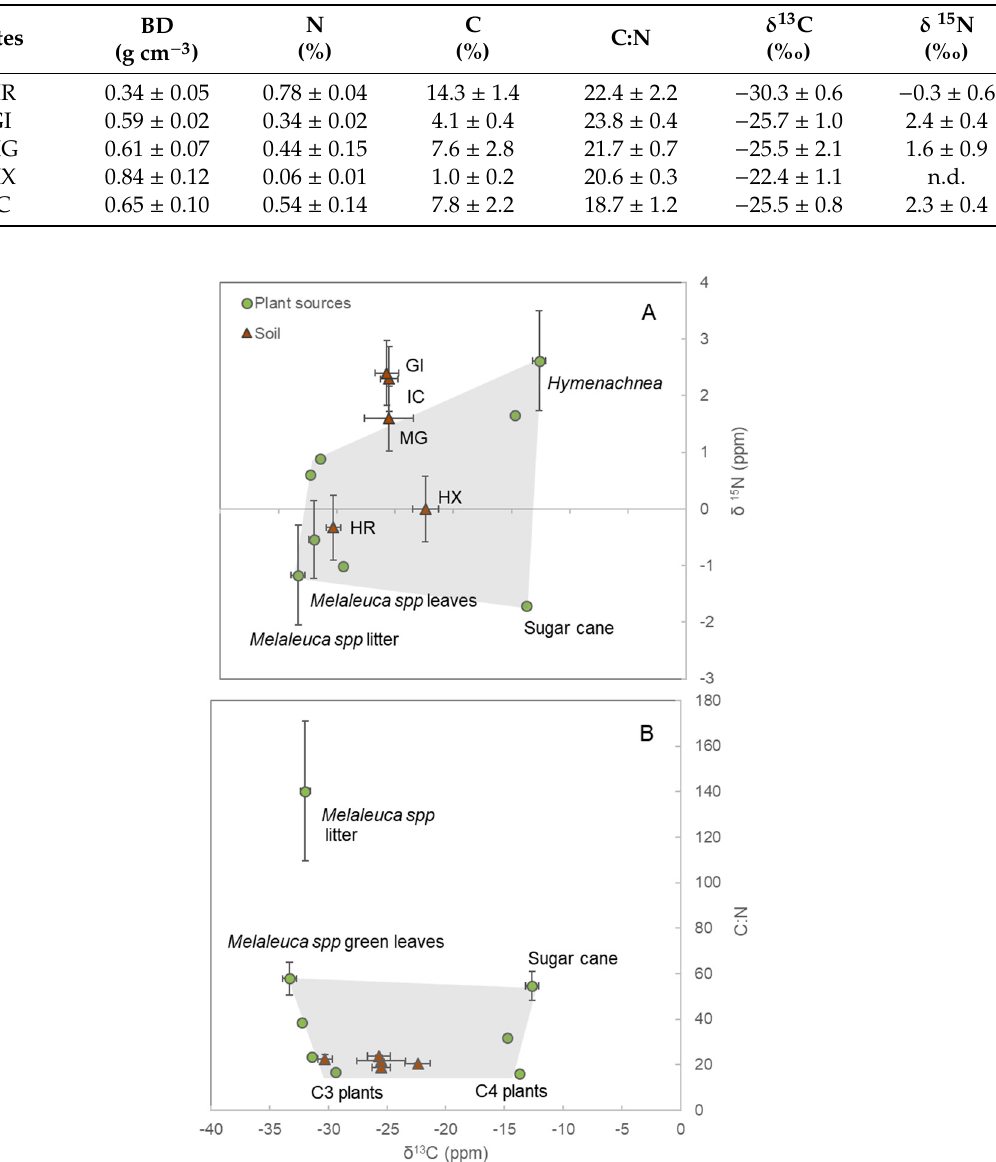
Table 2). The δ 15 N values could not be measured in HX due to very low N concentrations. Data for the chemical analyses of soil for the o ff shore sites (ZB and HI) were not available. Table 2. Surface (0–10 cm) soil characteristics (BD = bulk density, N = nitrogen, C = organic carbon, C:N = atomic ratio) of five forested floodplain wetlands, n.d. = not detected. More detailed results from the chemical analysis of soil samples can be found in Adame et al. [6]. The full names and location of the sites can be found in Table 1 and Figure 1.